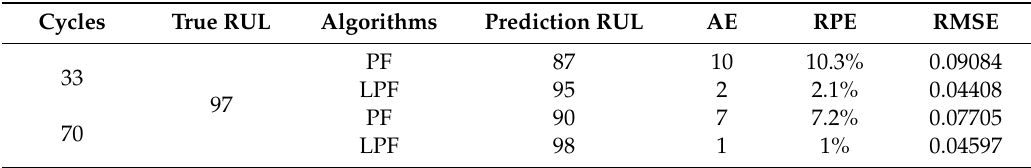
Figure 10. Capacity RMSEs for PF and LPF predictions: ( a ) Using 33 cycles as measurements; ( b ) Using 70 cycles as measurements. Table 3. Prediction Results for Battery B18.